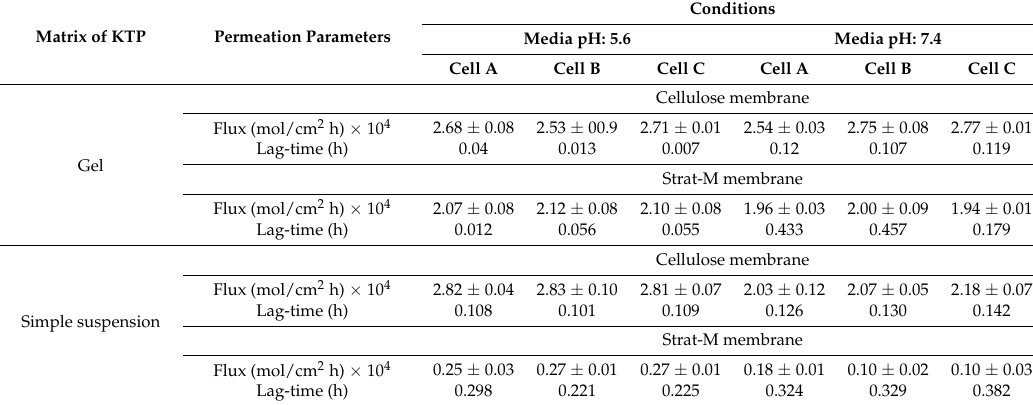
Table 3. AUC values for mass flux and lag time obtained from the KTP permeation profiles of the gel and the suspension using three cells and two membranes (cellulose and Strat-M membranes) in two media at 37 ◦